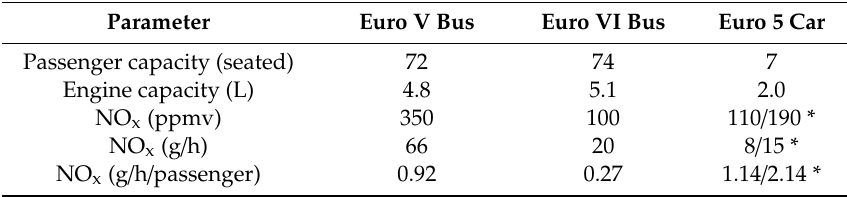
Table 2. Idling NO x mass emissions